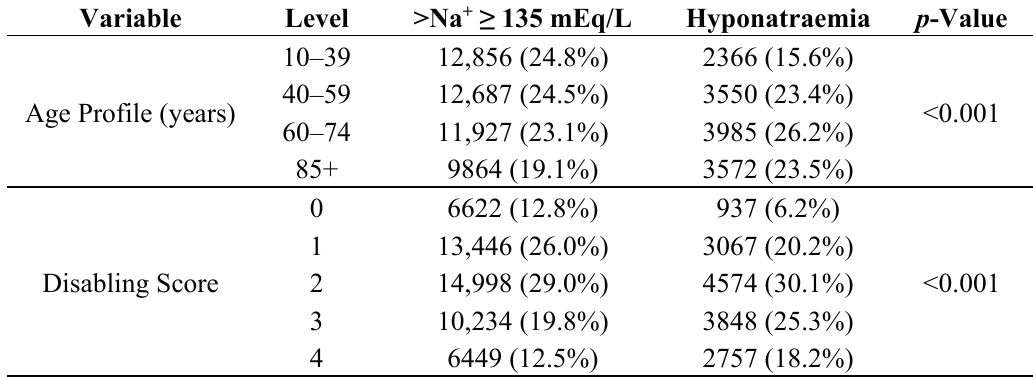
Table 2. Age, disabling disease and acute illness severity by admission Na +